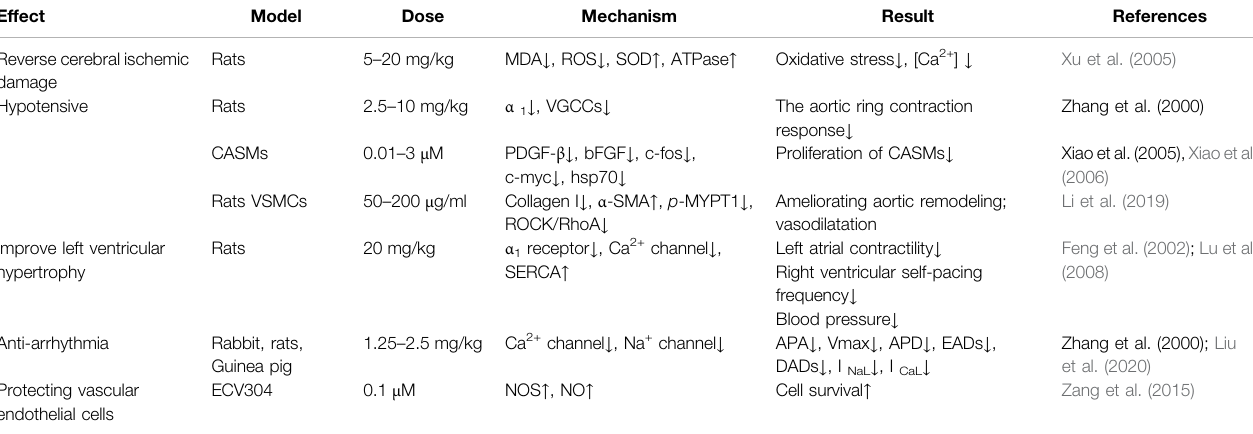
TABLE 2 | Cardiovascular protective activity of